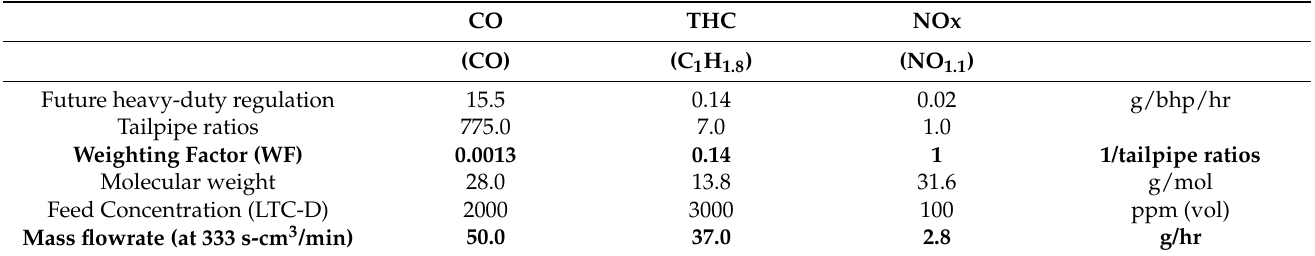
Figure 3. Overall conversions for CO, THC, and NOx in the temperature window below 250 ◦ C over several multi-component physical mixture reactor beds. Ratios in parentheses represent the mass ratio of the different components in the sample, respectively. Table 1. Key parameters and variables used for emissions merit function